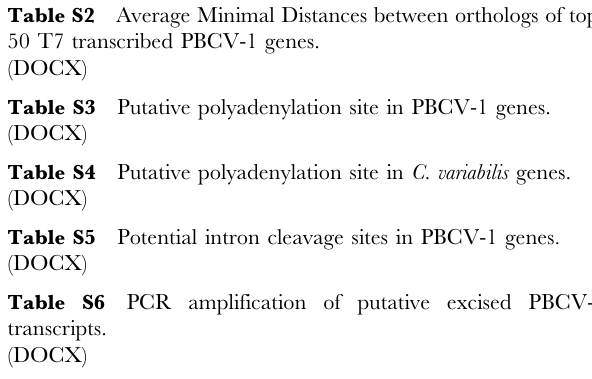
Figure S4 sequence logo representation showing nucle- otide biases around poly(A) cleavage sites. Figure S5 Agarose gel electrophoresis of PCR-amplified products representing targeted PBCV-1 transcripts. Table S1 MRPN values for virus and host genes. Table S2 Average Minimal Distances between orthologs of top-